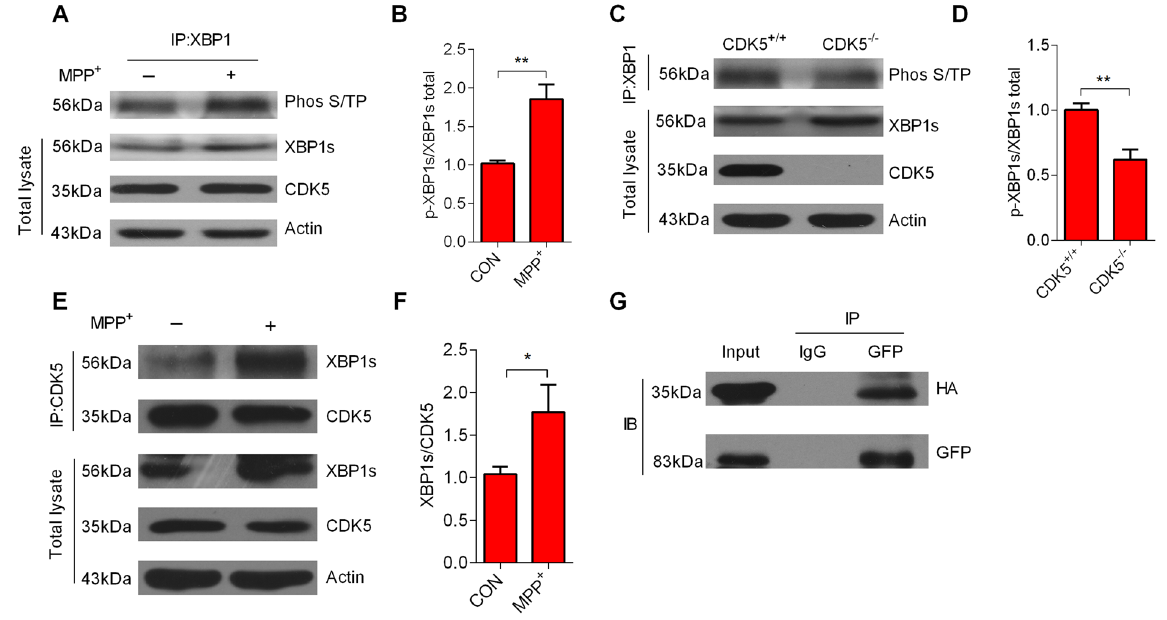
Figure 2. CDK5 mediates the phosphorylation of XBP1s. ( A ) The expression level of phospho-XBP1s (p-XBP1s) was increased in neurons treated with MPP + (100 μ M) for 12 h. Immunoprecipitation was performed using an XBP1 antibody with neuron total lysates, and then samples were analyzed by immunoblotting using a Phos S/T antibody. ( B ) The relative level of p-XBP1s protein in neurons was quantified by densitometry. ( C ) CDK5 phosphorylated XBP1s in CDK5 + / + but not CDK5 − / − mouse brain lysates. Immunoprecipitation was performed using an XBP1 antibody with cortical tissue lysates from CDK5 knockout mice, and then samples were analyzed by western blotting using a Phos S/T antibody. ( D ) The relative level of p-XBP1s protein in CDK5 + / + and CDK5 − / − mouse brain lysates was quantified by densitometry. ( E ) The interaction between XBP1s and CDK5 was increased in MPP + -treated neuron total lysates. Immunoprecipitation was performed using a CDK5 antibody with or without MPP + -treated neuron extracts, and then samples were analyzed by immunoblotting using an XBP1 antibody. ( F ) The graph is the quantification of the co-immunoprecipitations. ( G ) XBP1s co-immunoprecipitated with CDK5 in HEK293 cell lysates that co-expressed XBP1s and CDK5. HEK293 cells were co-transfected with HA-CDK5 and GFP-XBP1s WT plasmids, and then collected and analyzed 24 h after transfection. Subsequently, CDK5 was immunoprecipitated with a GFP antibody, and the precipitate was blotted with an HA antibody specific for CDK5. Data are mean ± s.d. of n = 3 independent experiments. Significance was determined by unpaired Student’s t test (B, D and F). * P < 0.05, ** P <